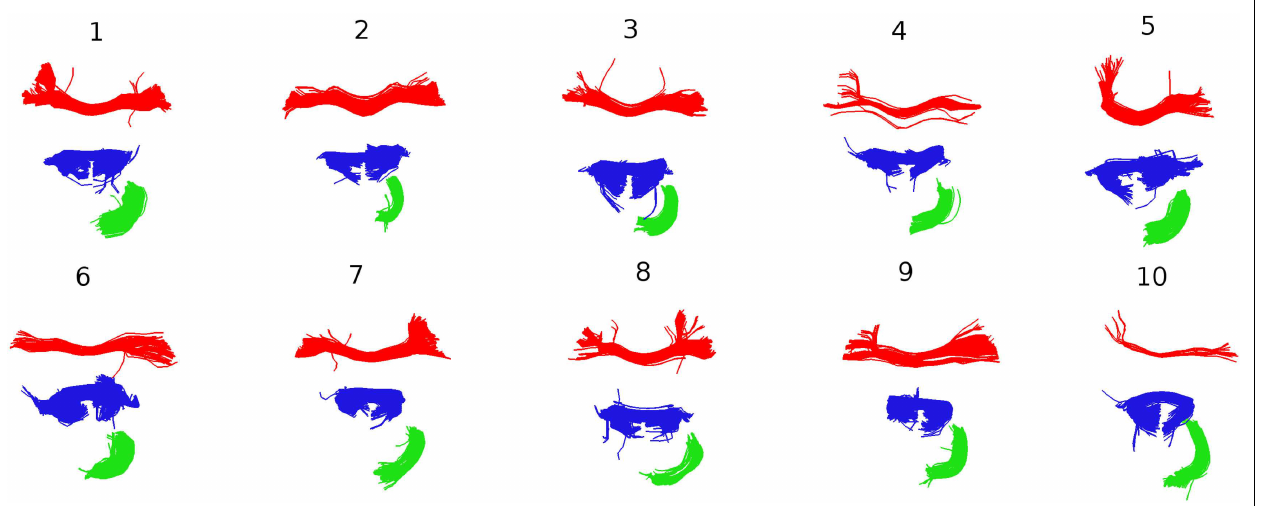
FIGURE 8 | Following Figure 7, the three largest clusters for subject 1 are shown together with the corresponding clusters in the other nine subjects. The correspondence is established by finding the centroids in subjects 2–9 that are nearest to the three centroids for subject 1.